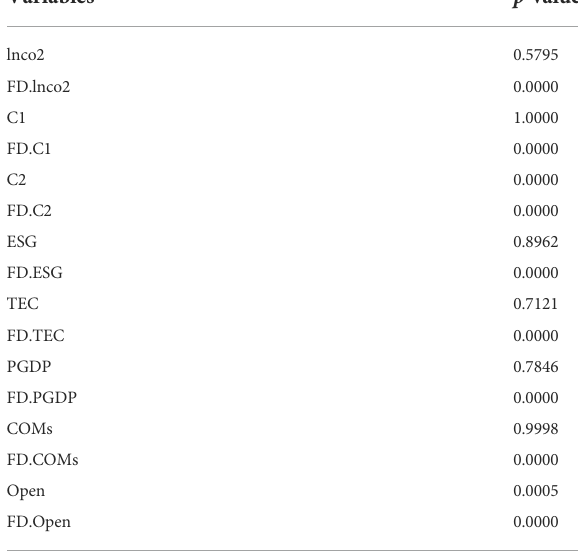
TABLE 4 Unit root test for variables and their fi rst difference.